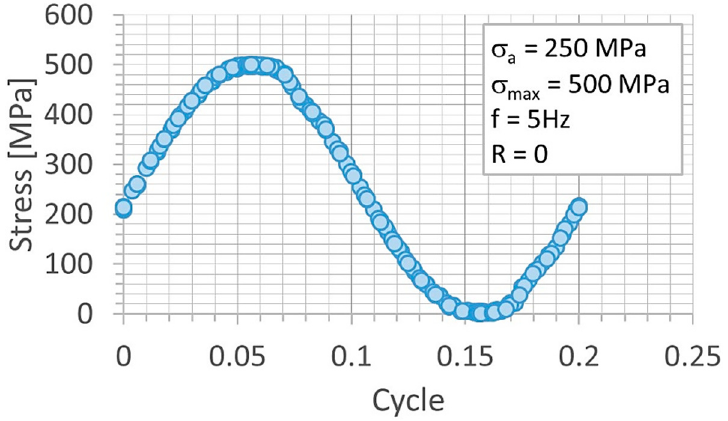
Figure 9. Stress signal at amplitude of 250 MPa and maximum value of 500 MPa, frequency 5Hz.